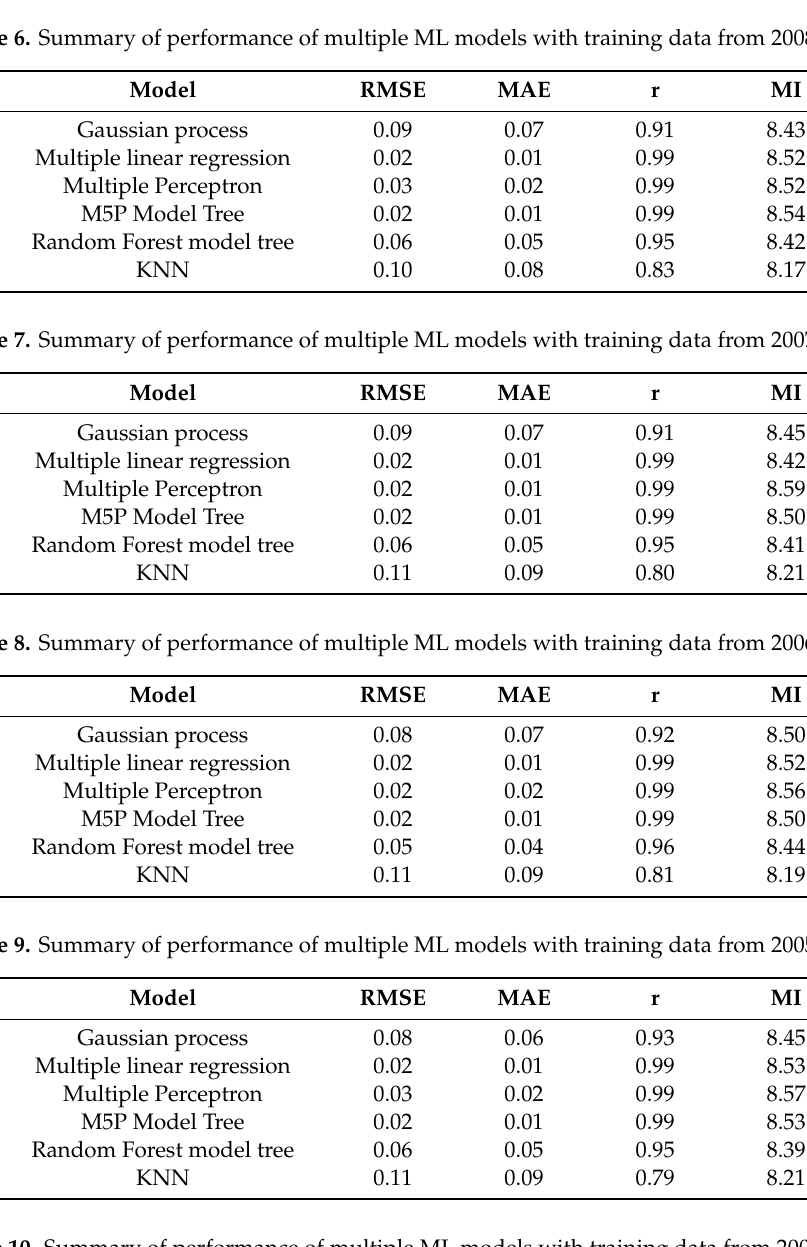
Table 10. Summary of performance of multiple ML models with training data from 2004 to